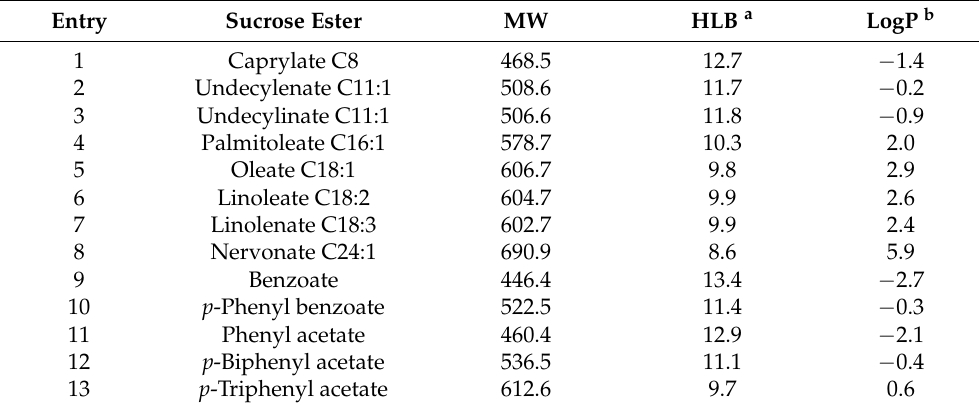
Table 1. Calculated physicochemical properties of the sucrose-based ester surfactants.